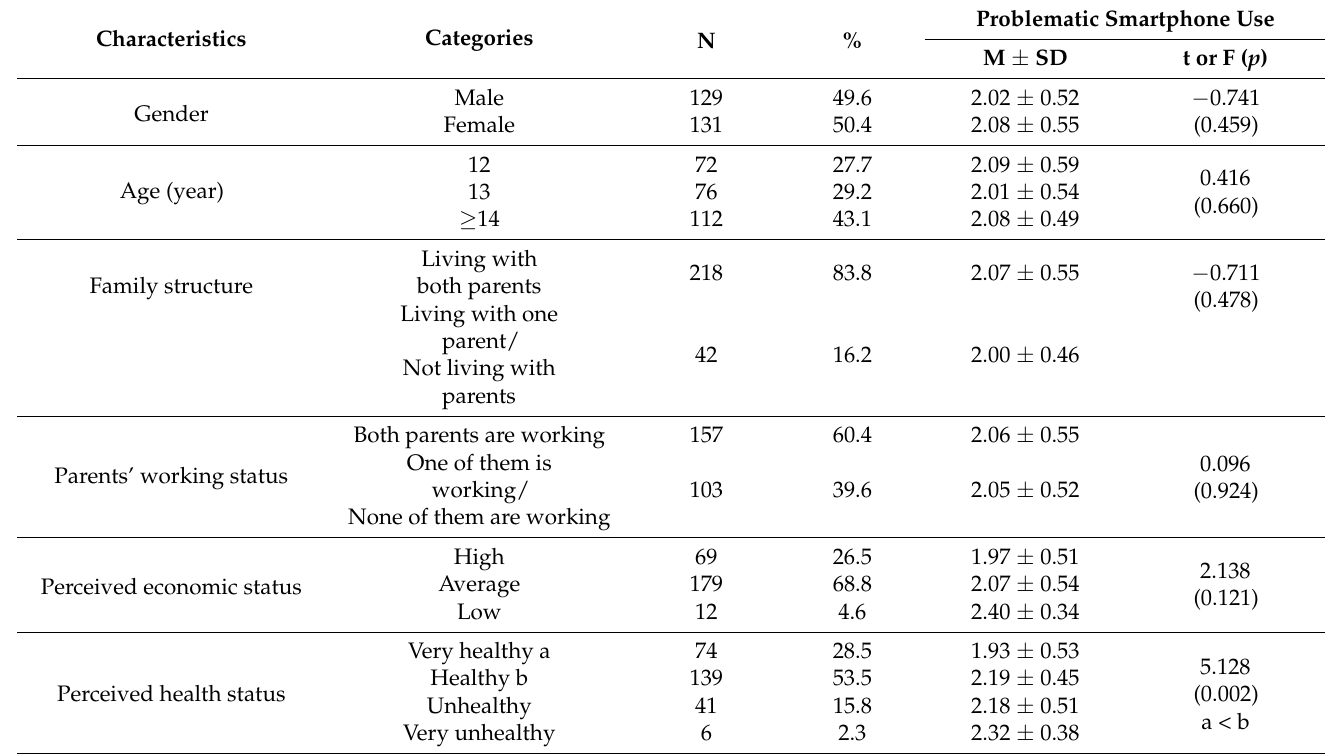
Table 1. Problematic smartphone use by sociodemographic characteristics.